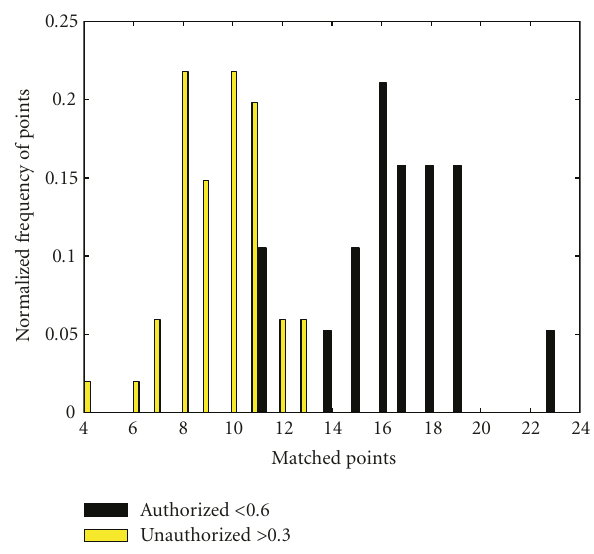
Figure 14: Histogram of matched points in the populations of attacks whose similarity is higher than 0 . 3 and clients accesses whose similarity is lower than 0 .